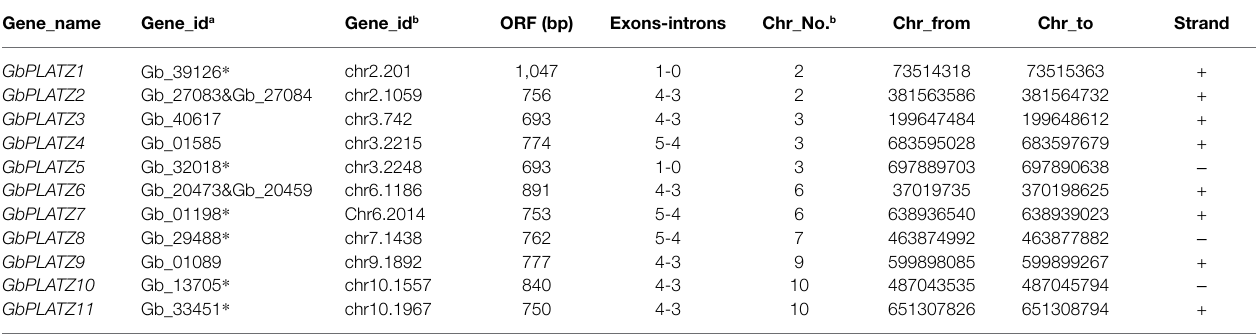
TABLE 1 | Eleven GbPLATZs identified from the complete genome of Ginkgo biloba